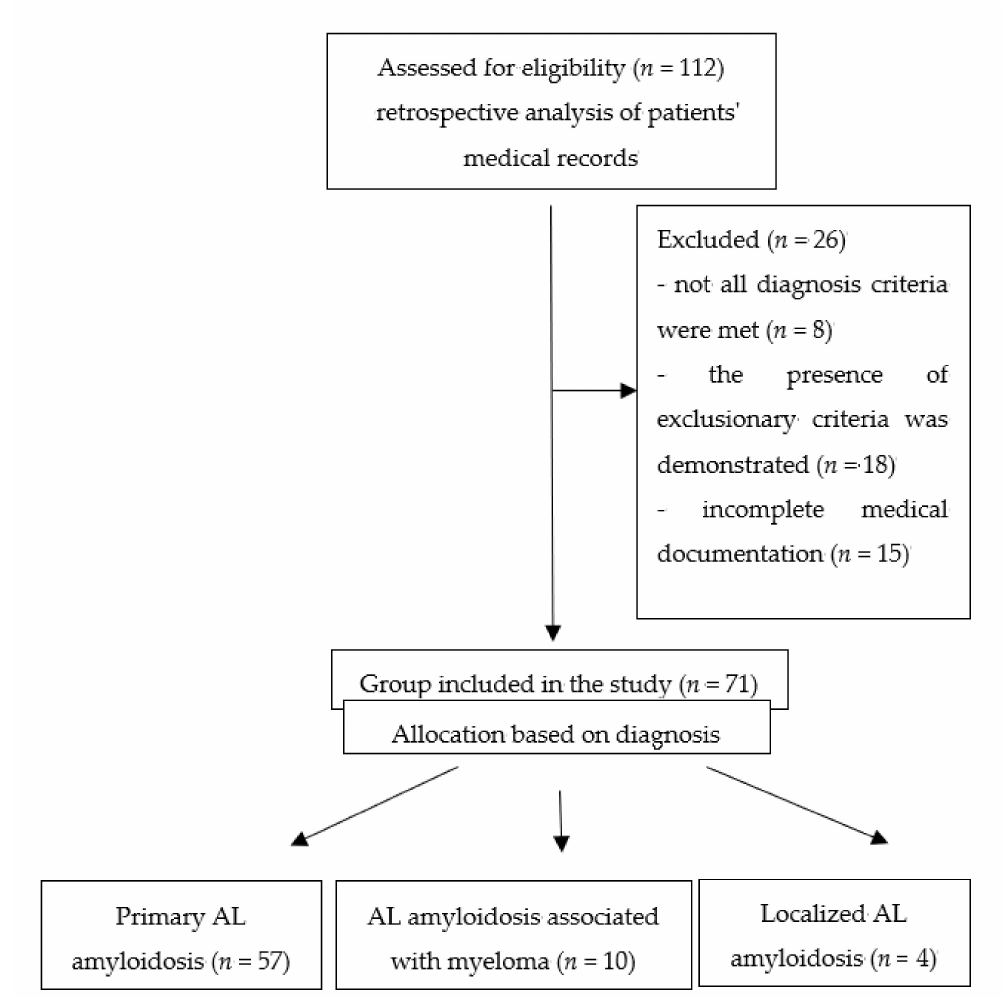
Figure 1. CONSORT diagram—study group selection. AL-Amyloid light-chain Comparative studies included type of monoclonal light chain forming amyloid (k, λ ); percentage of plasmocytes with trepanobioptosis at the time of diagnosis; echocardiog- raphy parameters, including LV (left ventricular and diastolic dimension), IVS (diastolic ventricular size), PW (left ventricular diastolic wall thickness), RV (right ventricular and diastolic dimension), and EF (left ventricle ejection fraction); laboratory findings, including NT-proBNP, TnI concentrations as parameters assessing cardiac dysfunction and damage, the concentration of free k and λ chains in serum, difference between the concentration of involved and uninvolved free light chain (dFLC), and the free k and λ light chain ratio (k/ λ ). The number of the analyzed data was not equivalent to the patients’ number. The results were evaluated, including both diagnosis and treatment monitoring. In addition, the commissioned test panels did not cover the compared parameters each time. The study population was a very diverse group in terms of frequency, number, and type of commis- sioned tests. There were patients monitored every two months for four years, including those who had a one-day stay at the hospital. Laboratory findings and echocardiography were performed in groups based on type of monoclonal amyloid-forming chain (k, λ ); FLC ratio (k/ λ ): <0.26, 0.26–1.65, >1.65; dFLC: <180 and >180 mg/L; clinical stage based on Ku- mar et al.’s [5] prognostic classification, including TnT ≥ 0.025 ng/mL or TnI ≥ 0.07 ng/mL, NT-proBNP ≥ 1800 pg/mL, and dFLC ≥ 180 mg/dL (Stage I—0 factors, Stage II—1 factor, Stage III—2 factors, Stage IV—3 factors) and diagnosis (AL amyloidosis, AL amyloidosis associated with myeloma, localized AL